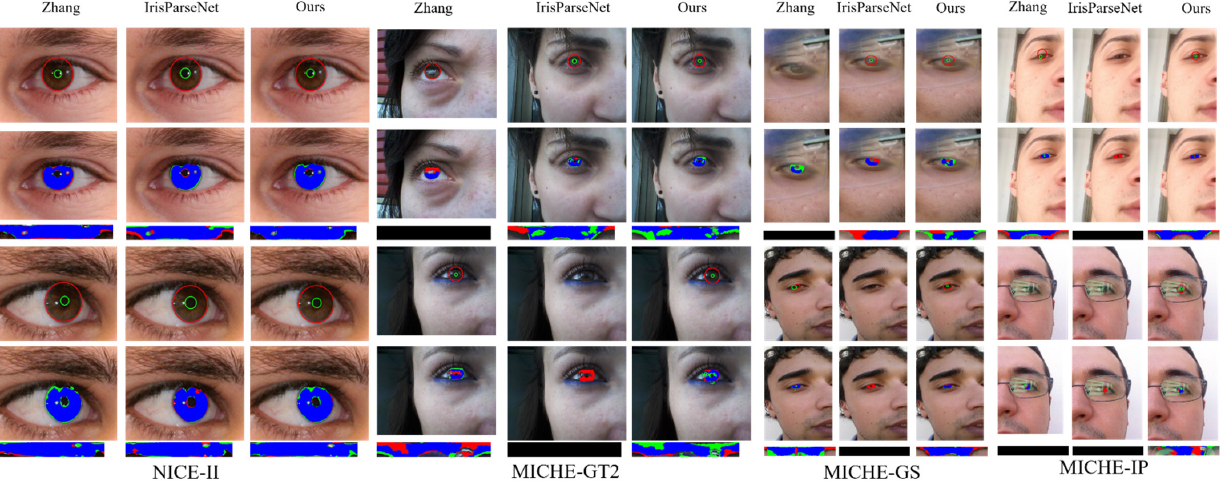
Figure 7. The results of the different methods on NICE-II [31] and MICHE [32]. For non-normalized and normalized masks, blue indicates true positive pixels, green represents false positive pixels, red represents false negative pixels. If locating the inner and outer circles fails, then the normalized iris result will be empty, which is indicated by a black bar image.